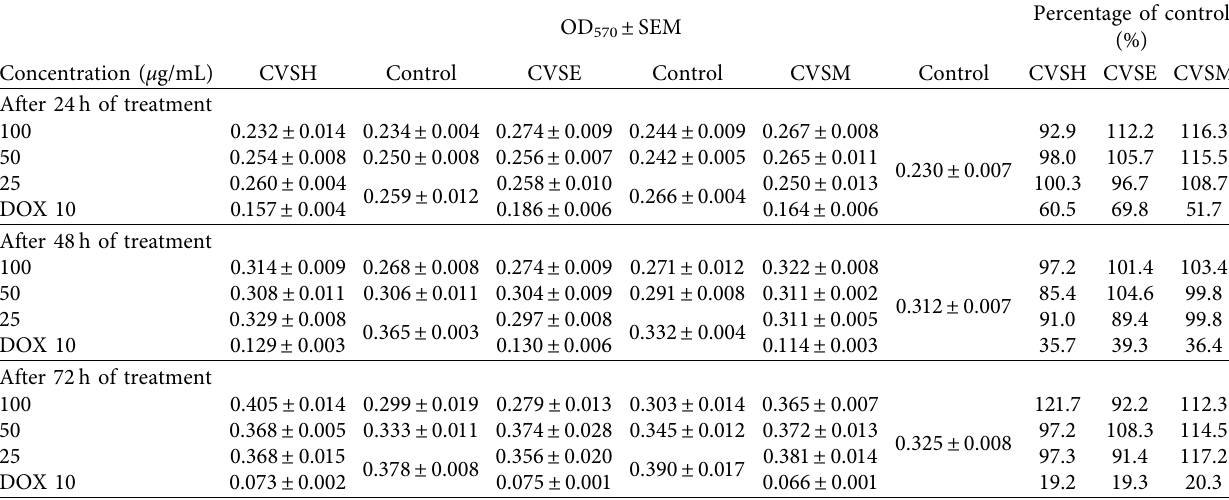
Table 3: The hepatoprotection of the methanol extracts of the stems of C. viscosa and C. chelidonii against CCl